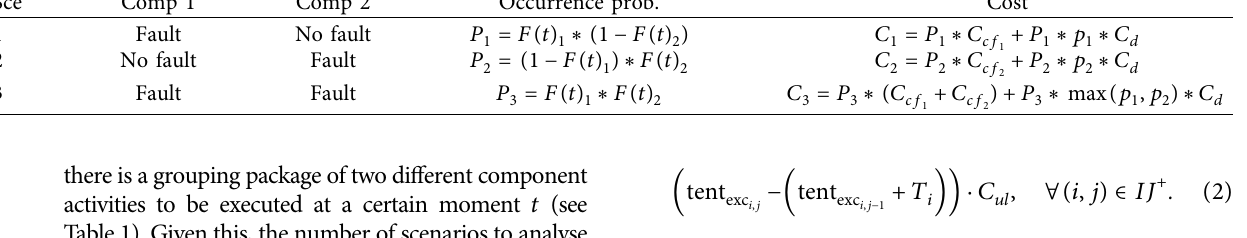
Table 1: Analysis of a two-components case, which shows how to calculate each of the three fault scenarios costs. Sce Comp 1 Comp 2 Occurrence